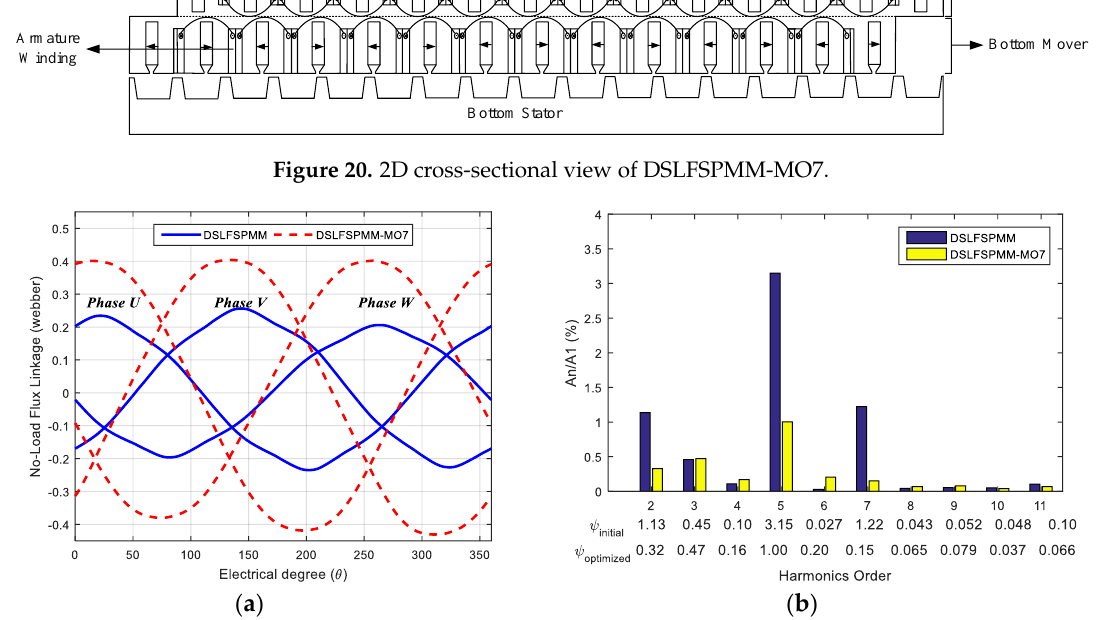
Figure 21. Comparison of DSLFSPMM and DSLFSPMM-MO7: ( a ) No-load flux linkage waveforms; ( b ) No-load flux linkage frequency spectrum.